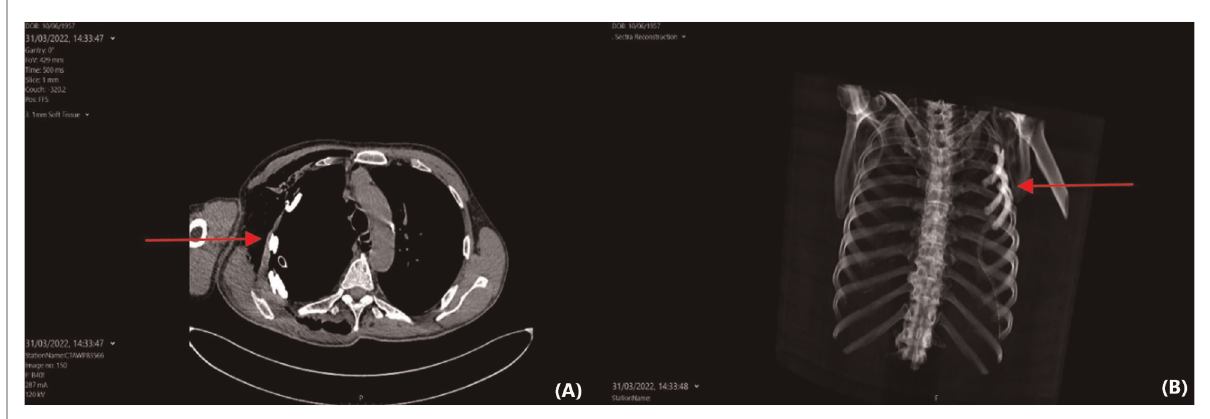
FIGURE 4. ( A ) Axial computed tomography of the thorax showing a personalised prosthesis contoured to the concavity of the chest wall and residing anatomically. ( B ) 3D reconstruction of the same computed tomography